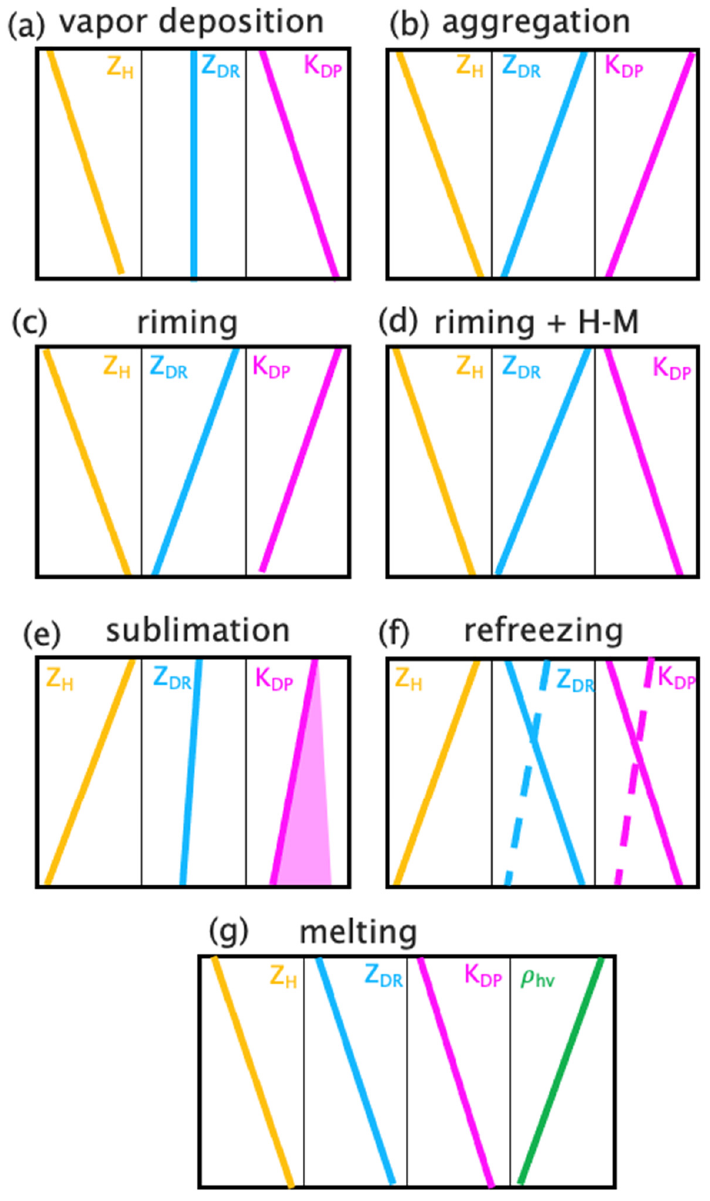
Figure 6. As in Figure 2, but for ice microphysical processes including ( a ) vapor depositional growth of ice crystals, ( b ) aggregation, ( c ) riming, ( d ) riming with the Hallett-Mossop rime splintering process occurring, ( e ) sublimation (including a range of possible increases in K DP owing to sublimational fragmentation identified by [88]), ( f ) refreezing (with dashed lines showing the refreezing of partially melted hydrometeors, and solid lines indicating the refreezing of fully melted hydrometeors), and ( g ) melting. Note in ( g ) the additional panel showing the reduction in 𝜌 hv associated with melting, given its importance for identifying this process.